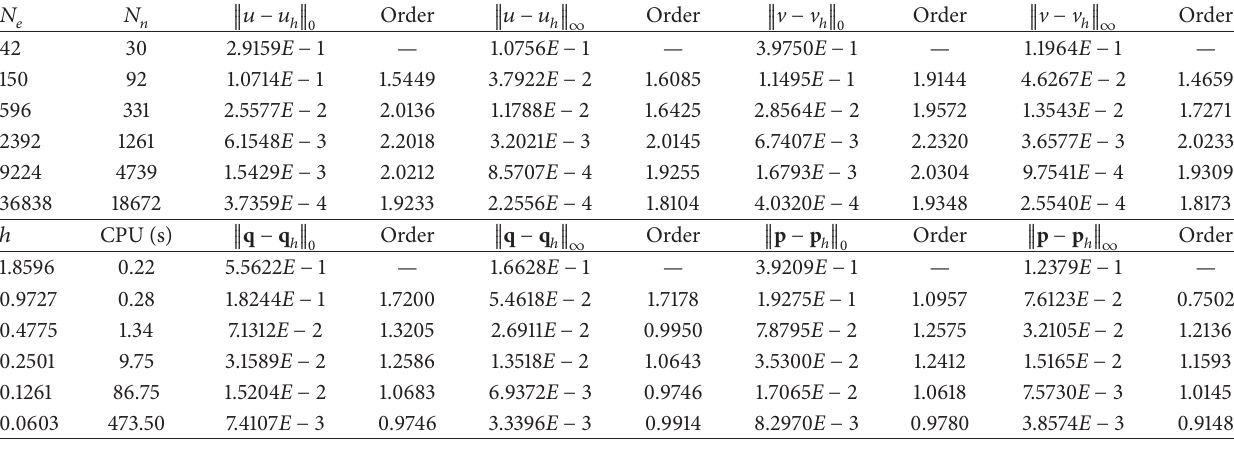
Table 1: Numerical results for Example 2 at 𝑇 = 0.5 .